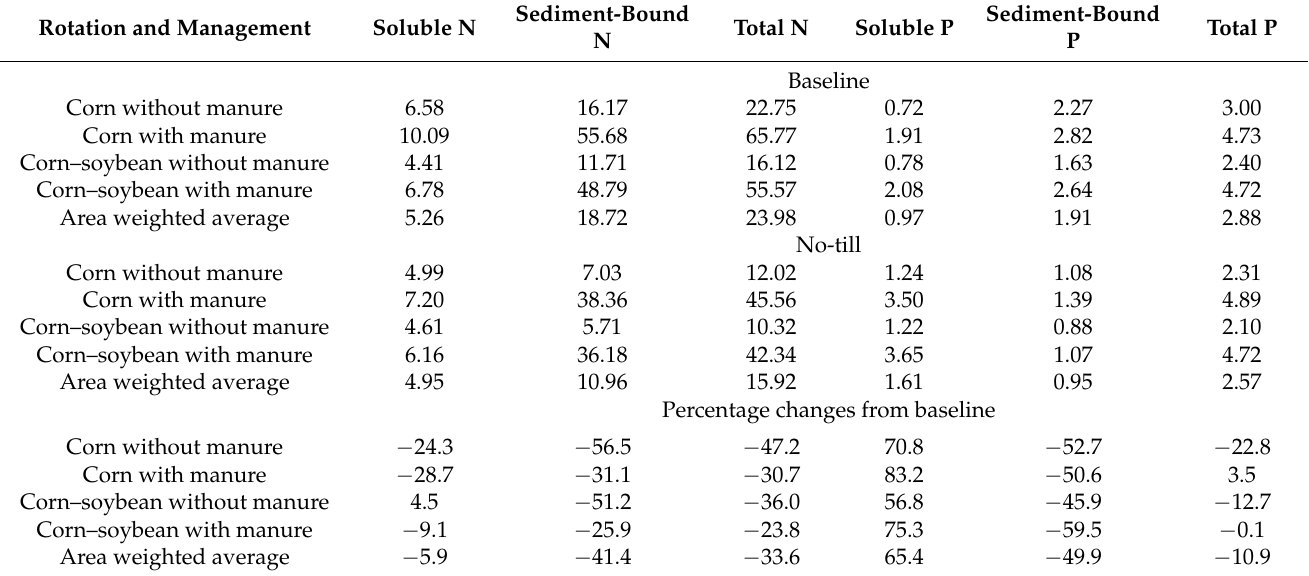
Table 6. Conservation tillage impacts on nutrient losses in surface runoff (kg/ha/yr)